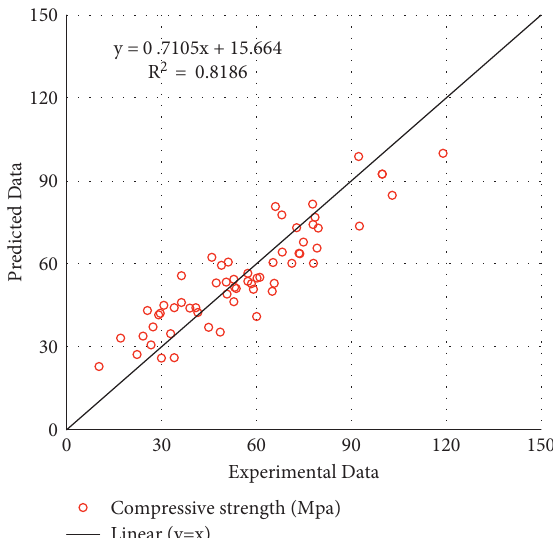
Figure 13: Compressive strength experimental versus predicted values for the multiple regression model using testing